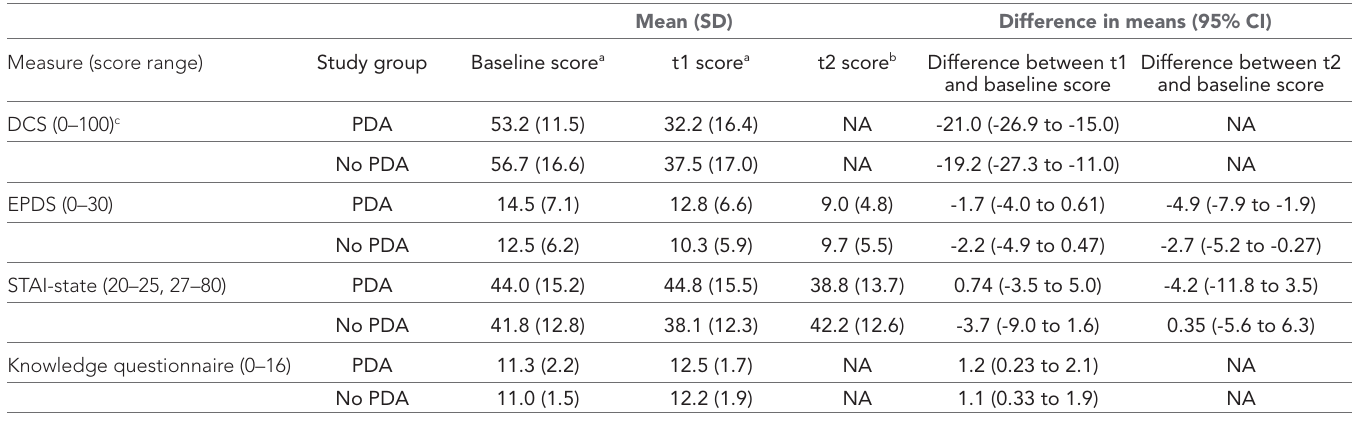
Mean (SD) Difference in means (95% CI)